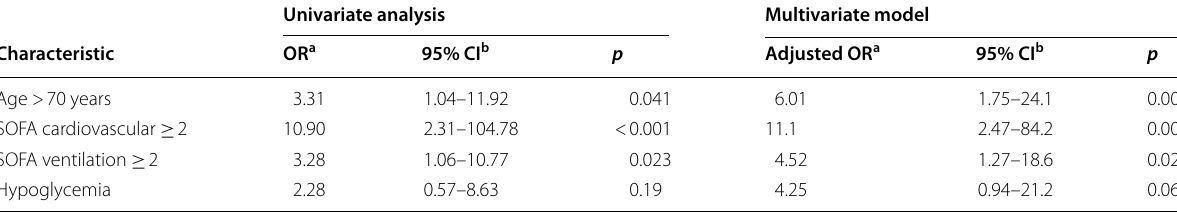
Table 3 Predictive factors associated with ICU mortality in critically‑ill adults with severe